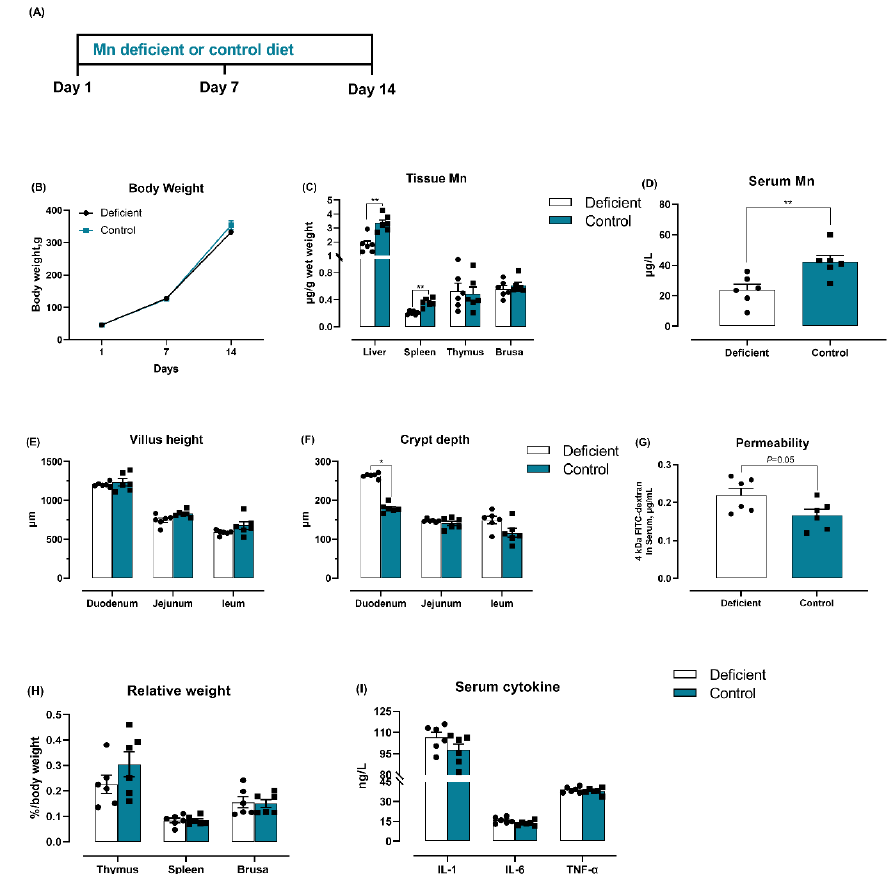
Figure 7. Dietary Mn deficiency itself induces intestinal impairment but did not affect systemic inflammation. ( A ) Schematic presentation of experimental design. Birds were fed with either the Mn-deficient or the control diet (the basal diet plus additional 0 and 40 mg Mn / kg, respectively). ( B ) Body weight was measured over the entire period. Levels of Mn were measured in ( C ) serum and ( D ) spleen, thymus, and bursa. The intestinal barrier was evaluated via ( E ) villus height and ( F ) crypt depth based on hematoxylin / eosin (H&E) staining, as well as ( G ) permeability using fluorescein isothiocyanate (FITC)-dextran. For systemic inflammation, ( H ) the relative weights of spleen, thymus, and bursa were examined, and ( I ) the serum inflammatory cytokines, including interleukin (IL)-1, IL-6, and tumor necrosis factor (TNF)- α were assessed. Data represent means with standard deviation. * p < 0.05; ** p <